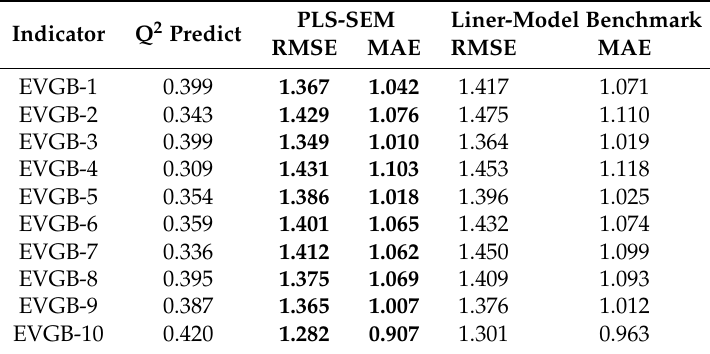
Table 5. Results of PLSpredict.